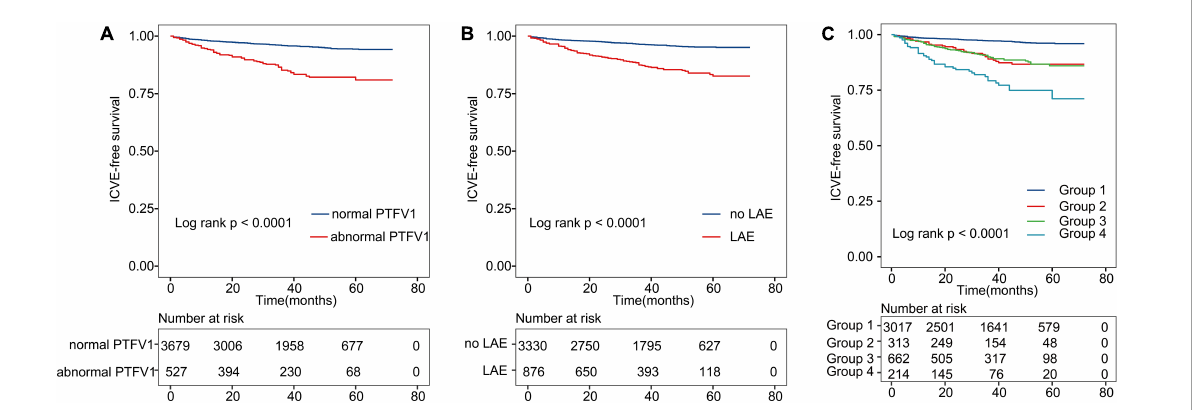
FIGURE3 Kaplan–Meier curves show ICVE-free survival. (A) Kaplan–Meier survival curves for abnormal PTFV1. (B) Kaplan–Meier survival curves for LAE. (C) All patients were divided into four categories. The lines represent the following: Group 1: patients with both normal PTFV1 and no LAE; Group 2: patients with abnormal PTFV1 and no LAE; Group 3: patients with LAE and normal PTFV1; Group 4: patients with both abnormal PTFV1 and LAE. ICVE, ischemic cerebrovascular events.